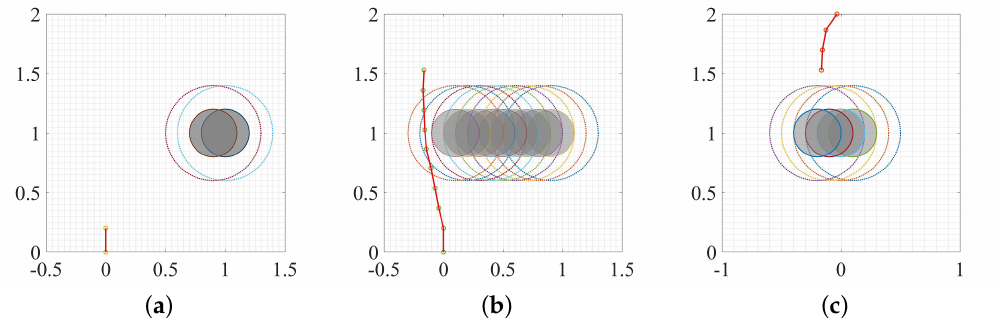
Figure 12. The robot uses the DIAPF approach to avoid a slow moving obstacle: ( a ) before avoiding; ( b ) avoiding the obstacle; and ( c ) finish